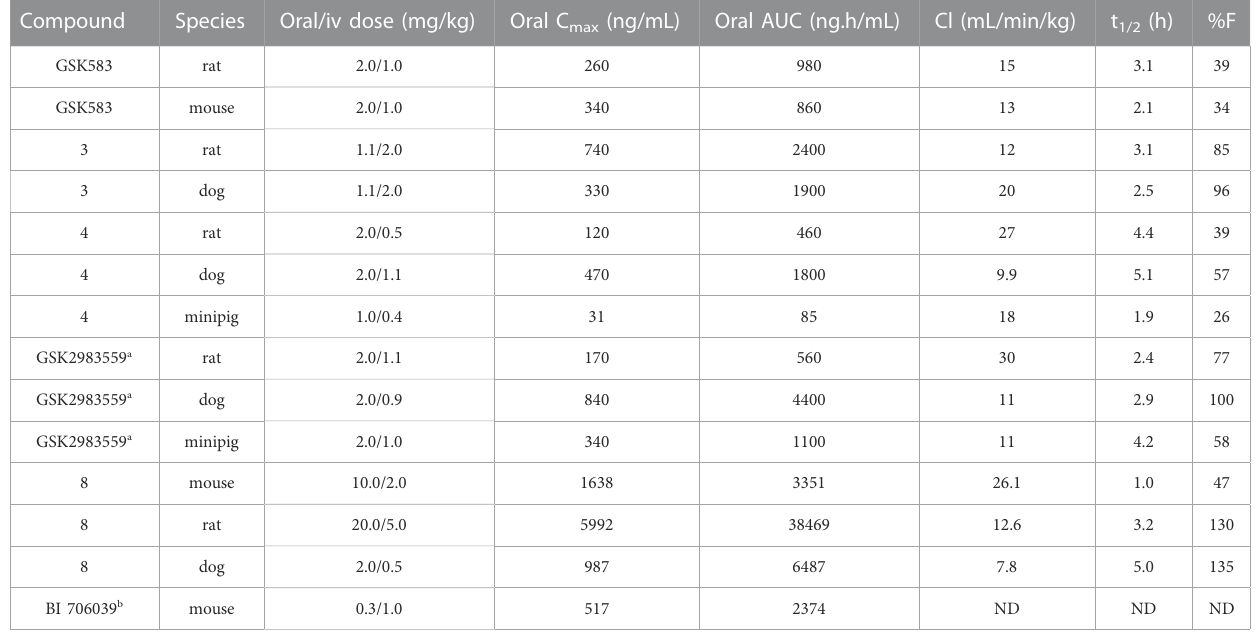
TABLE 1 PK parameters of selected RIPK2 inhibitors. Compound